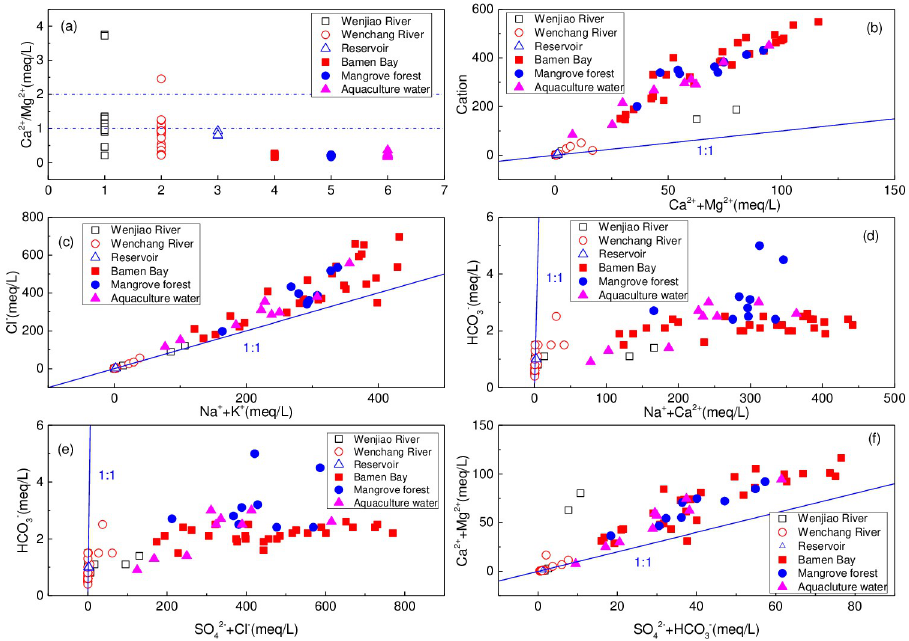
Fig 9. Plots of the ionic relationship of surface water chemistry in the Bamen Bay. (a) Ca 2+ /Mg 2+ , (b) cation vs. Ca 2 + /Mg 2+ , (c) Cl - vs. Na + + K + , (d) HCO 3- vs. Na + + Ca 2+ , (e) HCO 3- vs. SO 42- + Cl - , (f) Ca 2+ + Mg 2+ vs. SO 42- + HCO 3- .